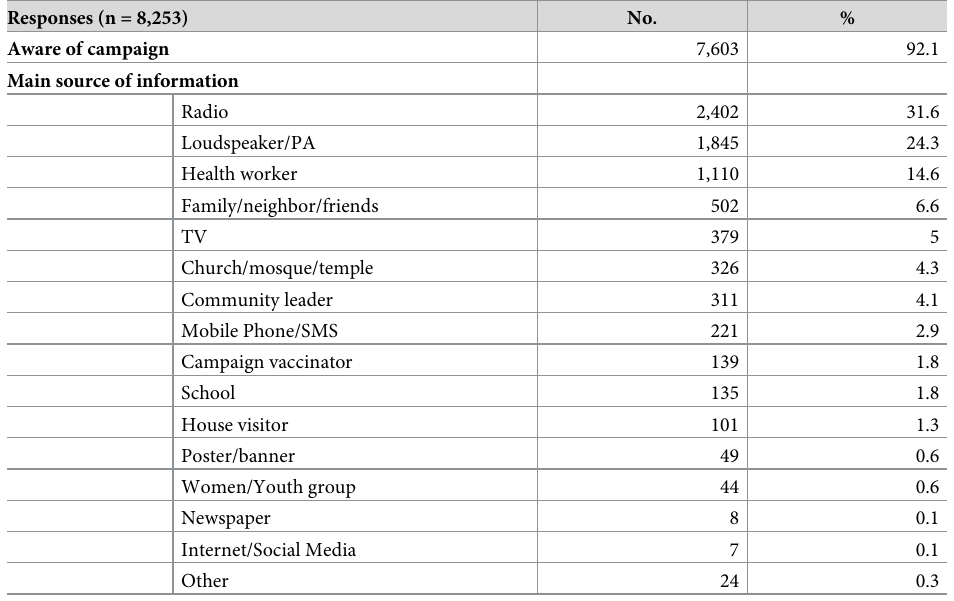
Table 3. Measles-rubella campaign awareness and main source of information reported by caregivers—Kenya, 2016. Responses (n = 8,253) No. % Aware of